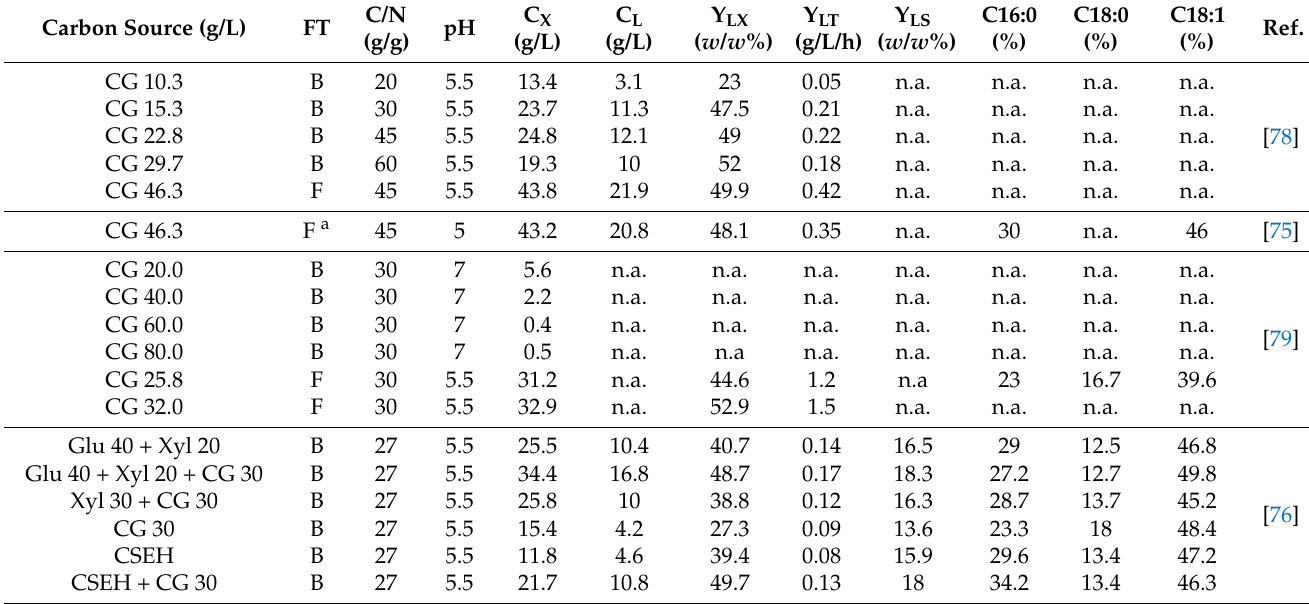
presence of the C/N ratio of 45, which led to obtaining a biomass production of 24.8 g/L, a lipid production of 12.1 g/L, a lipid content of 49 w/w % and a lipid productivity of 0.22 g/L/h. By replicating the same process conditions in combination with the fed-batch- mode fermentation, the authors obtained better results than the batch mode. In particular, the cell biomass concentration was 43.8 g/L, the lipid production was 21.9 g/L, the lipid content was 49.9 w/w % and the lipid productivity was 0.42 g/L/h. The improvement in biocatalyst performance in the fed-batch mode is related to the possibility to add a fresh substrate, properly tune the C/N ratio favouring different metabolic pathways, such as cell growth and lipogenesis, and dilute toxic compounds during the fermentation. Table 3. Bioconversion of glycerol to single-cell oil by the biocatalyst C. oleaginosus at 30 ◦ C. C/N Carbon Source (g/L) FT